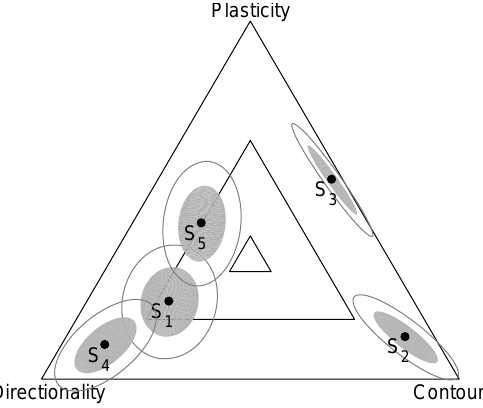
Figure 5. Results of experiment 3: mean values, 95% confidence regions (gray areas) and 99.9% confidence regions (gray ellipses) of the